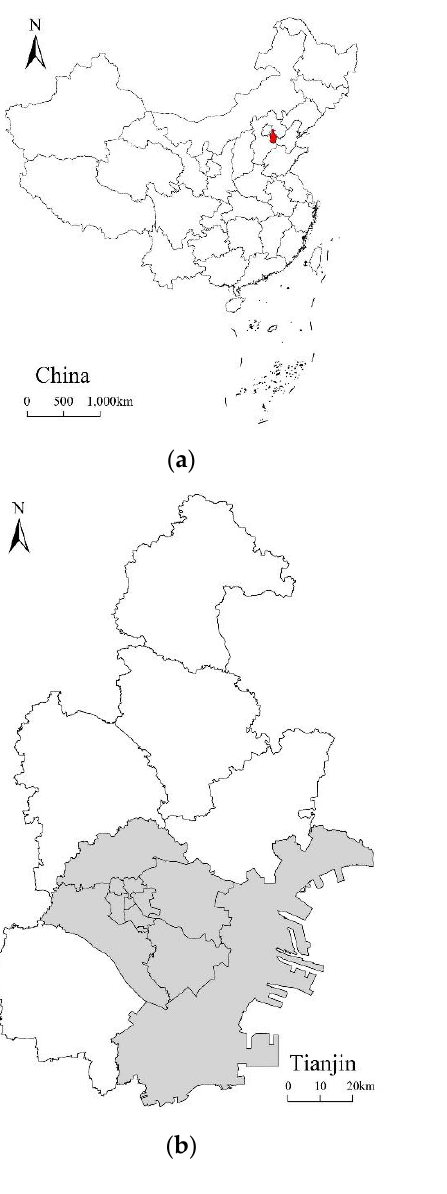
Figure 1. ( a ) Tianjin’s location in China; ( b ) The study area in Tianjin; ( c ) The macro-scale: Tianjin metropolitan area; ( d ) The meso-scale: Tianjin central area.